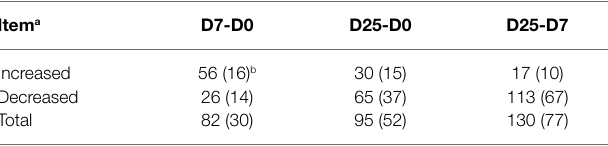
TABLE 1 | The number of differential metabolites in the liver after overfeeding. Item a